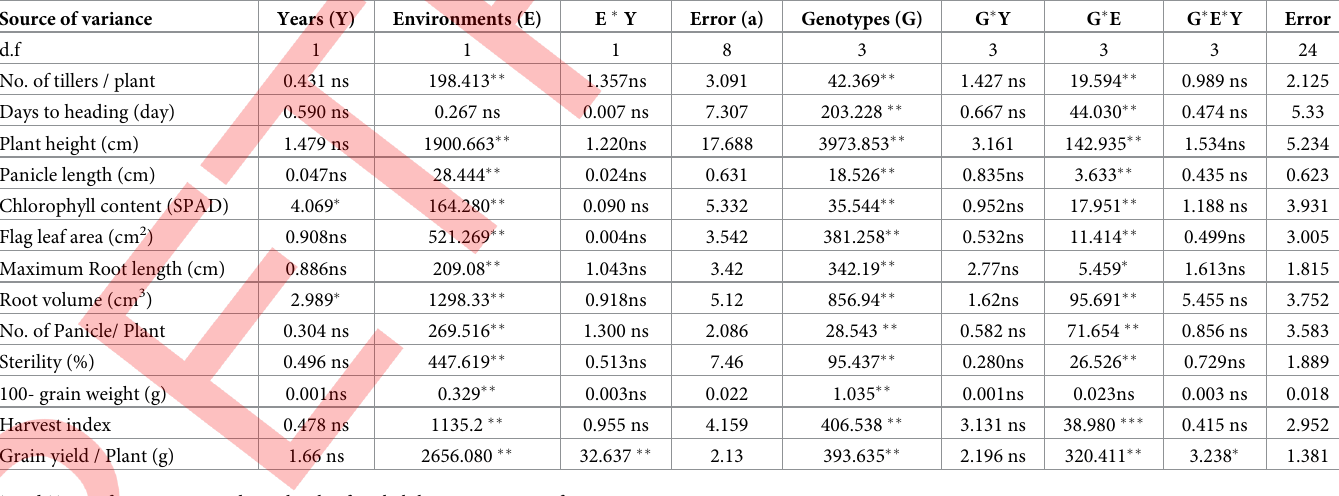
Table 1. Mean squares from analysis of variance for the studied traits over drought-stress and control